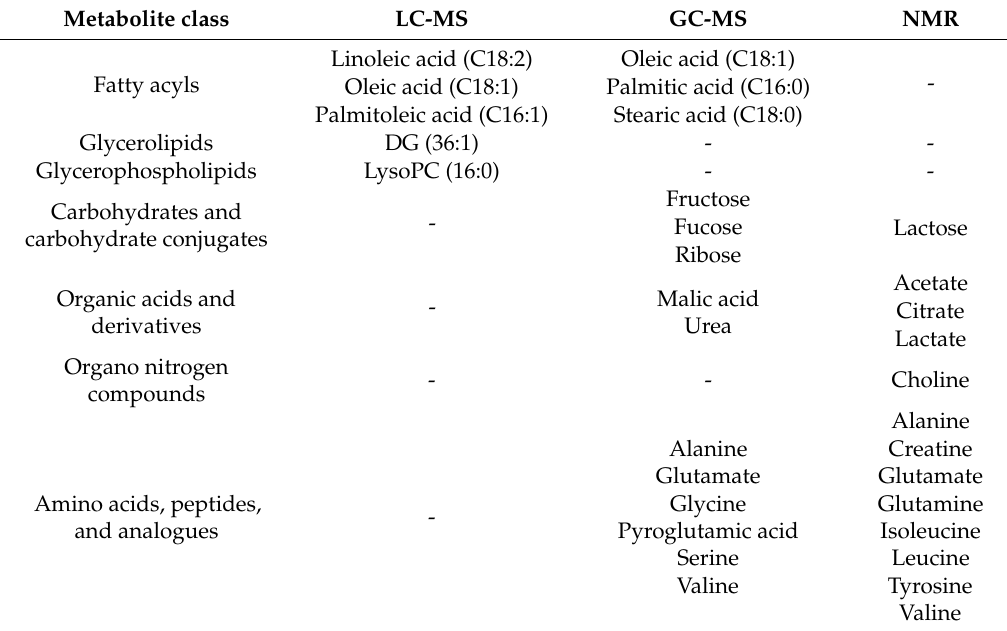
Table 2. Most frequently reported metabolites ( > 80% of studies) according to